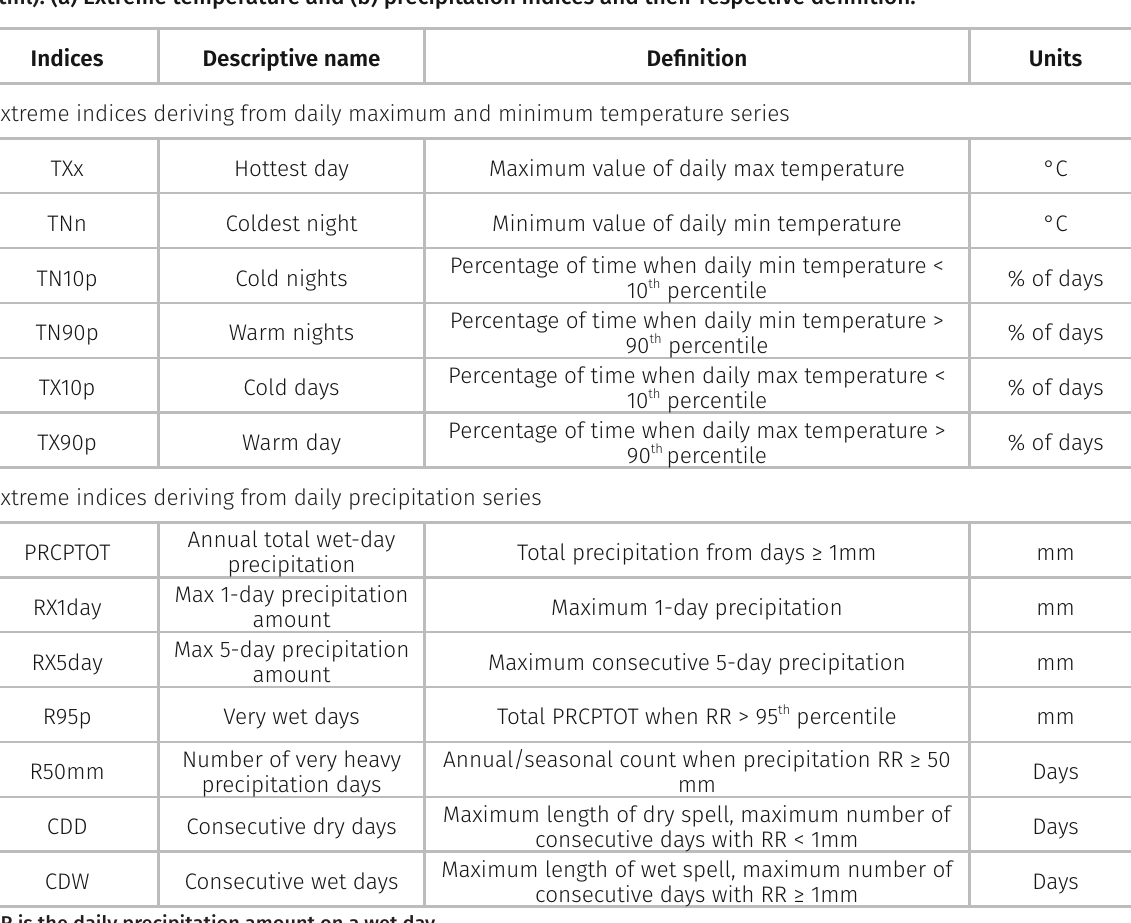
Table I. List of extreme indices recommended by ETCCDI (see